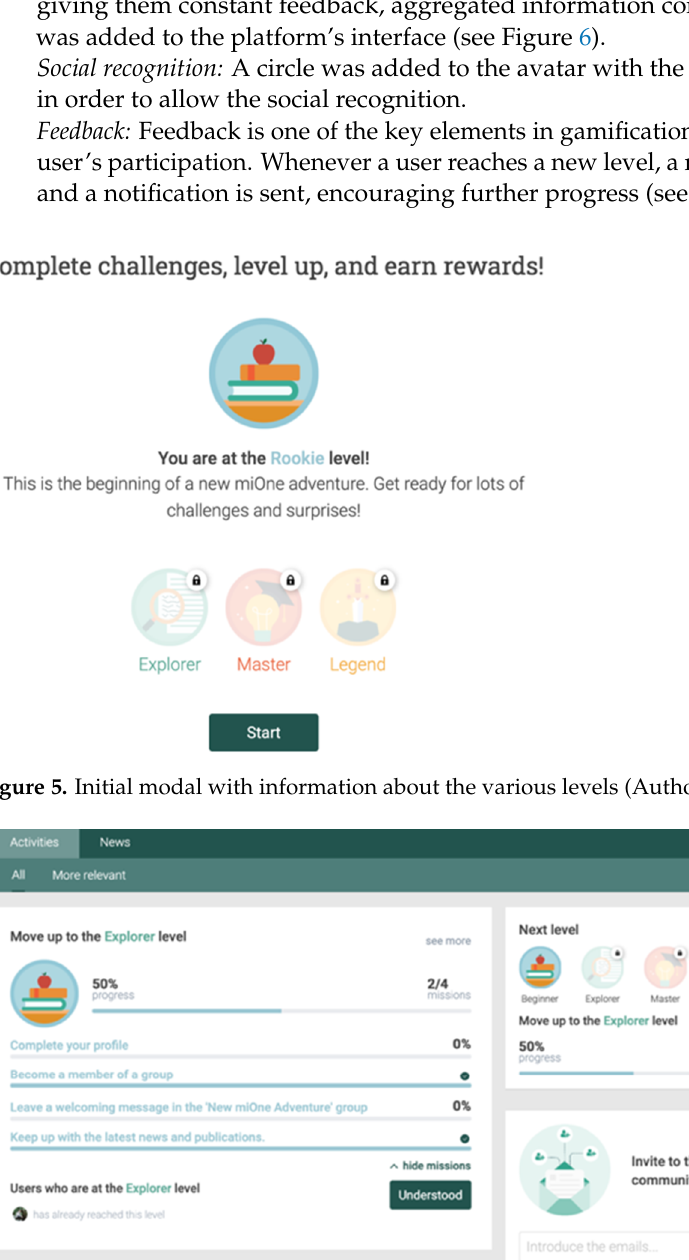
Figure 4. Endorsing awards modal (Authors’ copyright). Levels